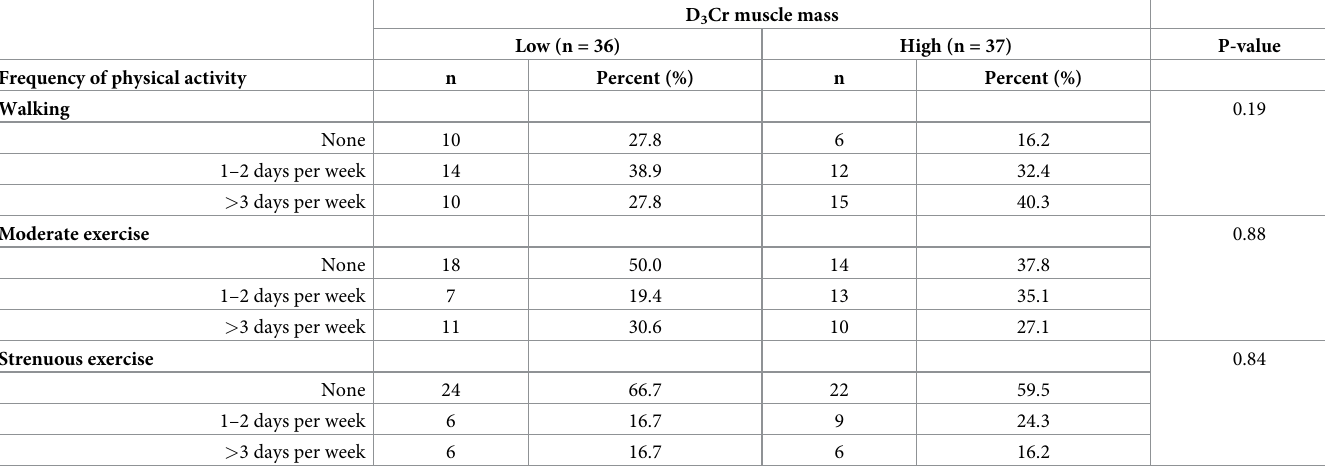
Table 2. Comparison of self-report exercise and physical activity patterns among women with high and low muscle